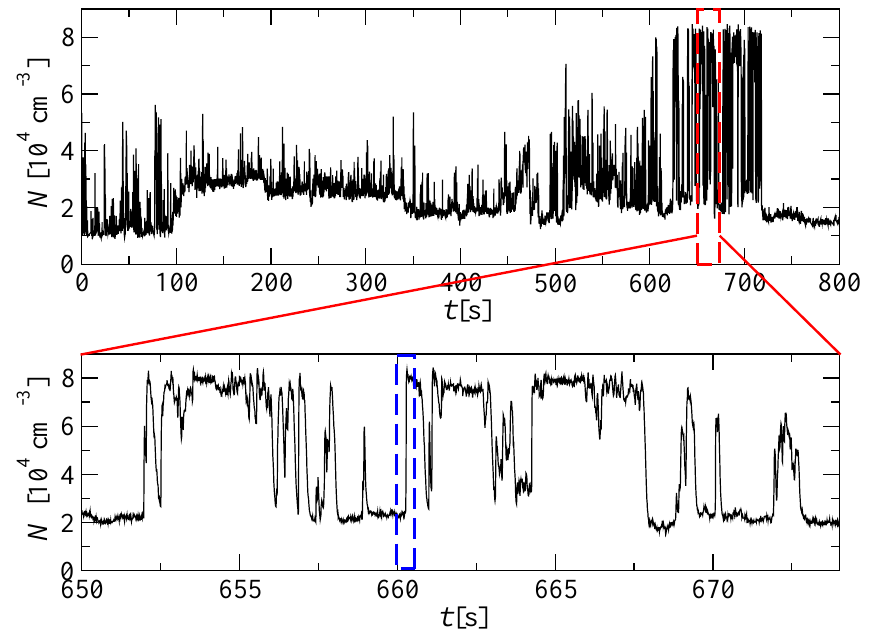
Fig. 8. Time series of particle number concentration N measured with the FCPC under atmospheric conditions, about 5m downstream of an artificial particle source (gasoline power generator). The sampling gate was 10ms. At the end of the record ( t ∼ 600–720s), the power generator was running out of gasoline resulting in an increased production of particles. The lower panel shows an enlarged portion of the record with strong variation of N due to the fluctuations of the wind direction and the particle production of the power generator. The blue box depicts a sharp ramp analysed in Fig.